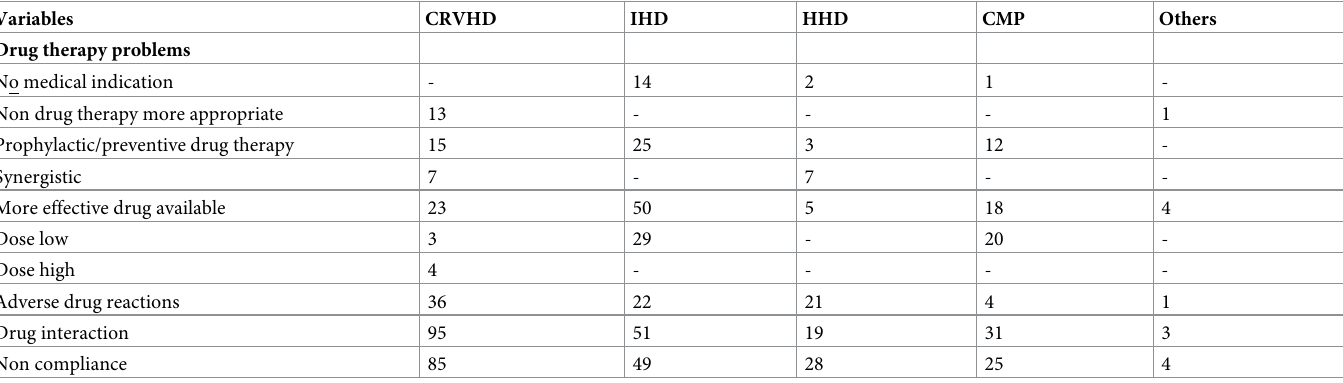
CMP: cardiomyopathy, CRVHD: chronic rheumatic valvular heart disease, IHD: ischemic heart disease, HHD: hypertensive heart